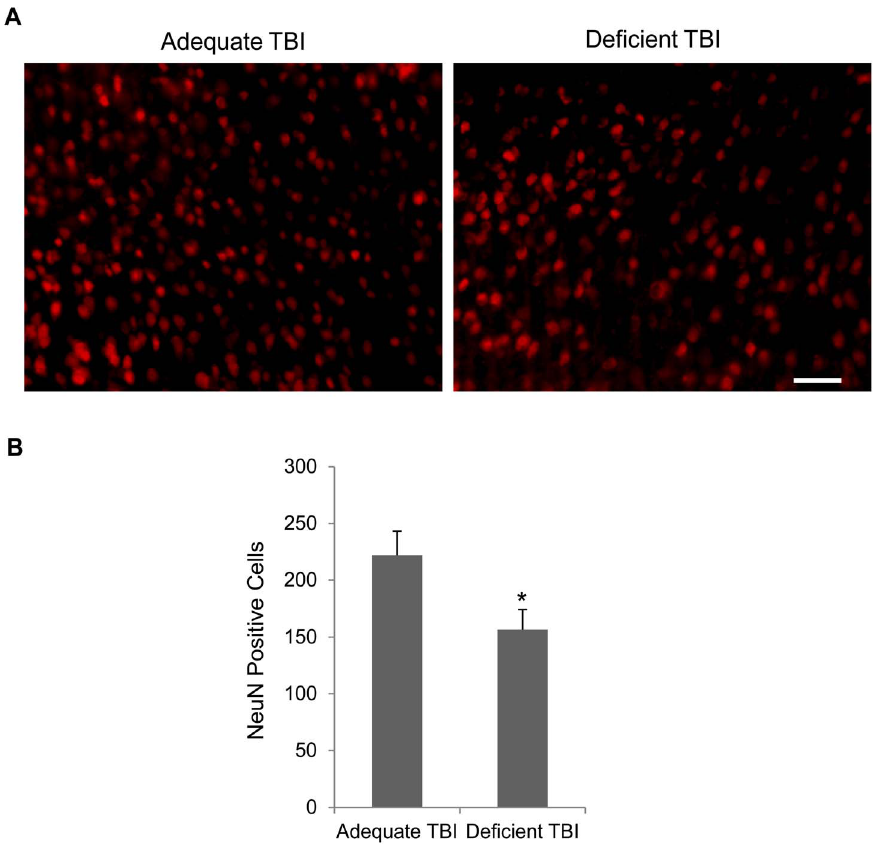
Figure 4. DHA deficiency decreases NeuN positive cells after TBI. DHA depleted mice showed decreased NeuN positive cells in the peri- contusional cortices relative to the DHA adequate mice as indicated by the representative micrographs (A) and quantitative analysis (B) of 25 brain sections from 5 mice. Scale bar = 50 m m. * p , 0.05.